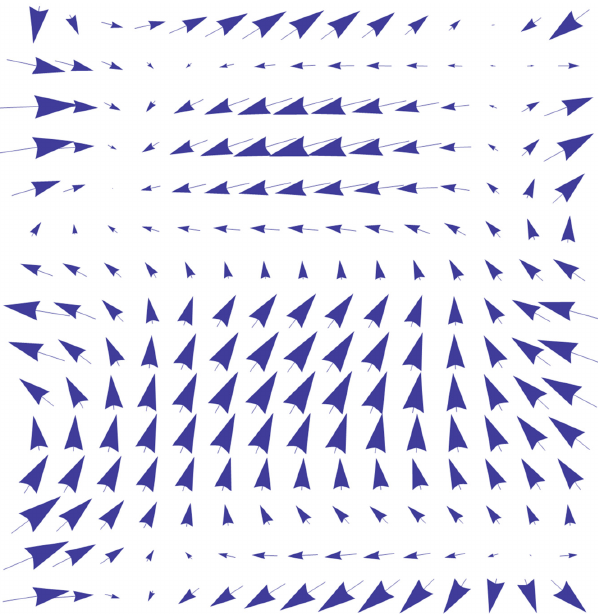
Fig 3. Wind field data. The data structure of the wind field is vector data. The strength of the wind force can be described by the size of the arrow of the wind field, in addition to the information on the direction of